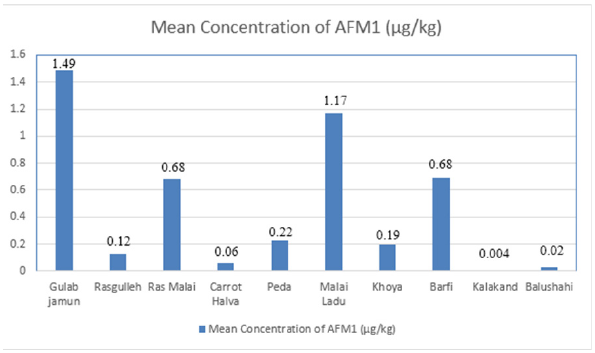
Figure 3: Comparison of AFM1 concertation in different Types of